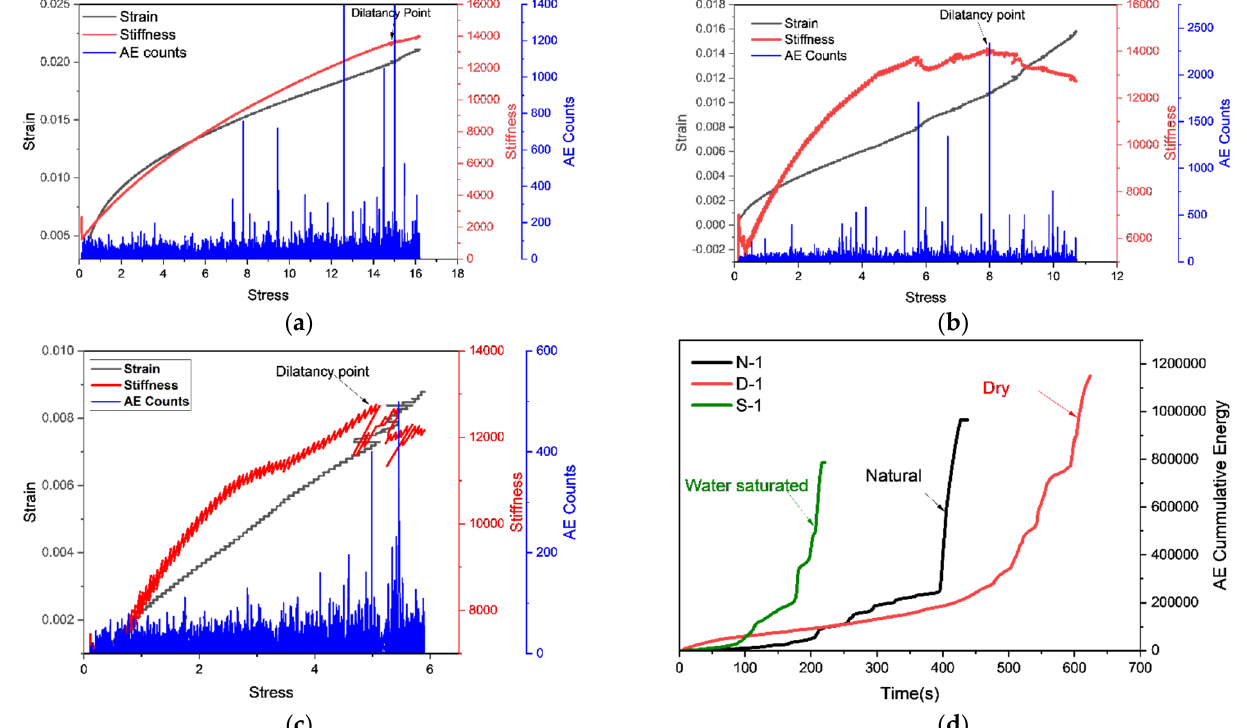
Figure 13. The relation of strain, stiffness, and AE counts with stress ( a ) dry sample, ( b ) natural sample, ( c ) saturated sample and ( d ) relation of time and AE cumulative